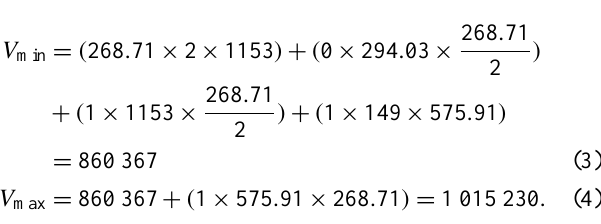
Table 2. Number of buildings significantly affected (deposit